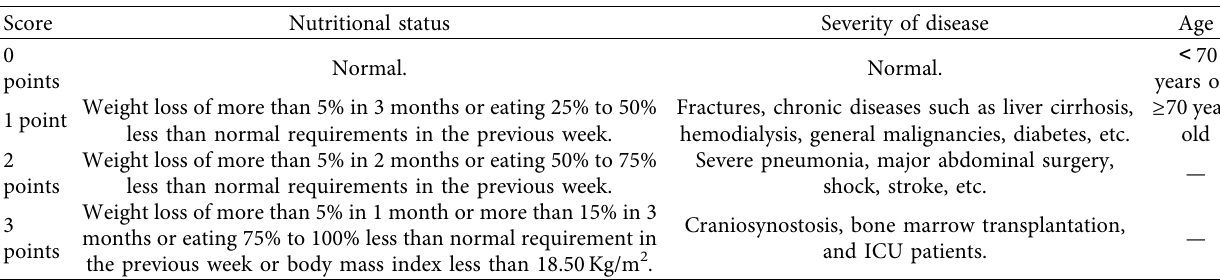
Table 1: NRS scores.